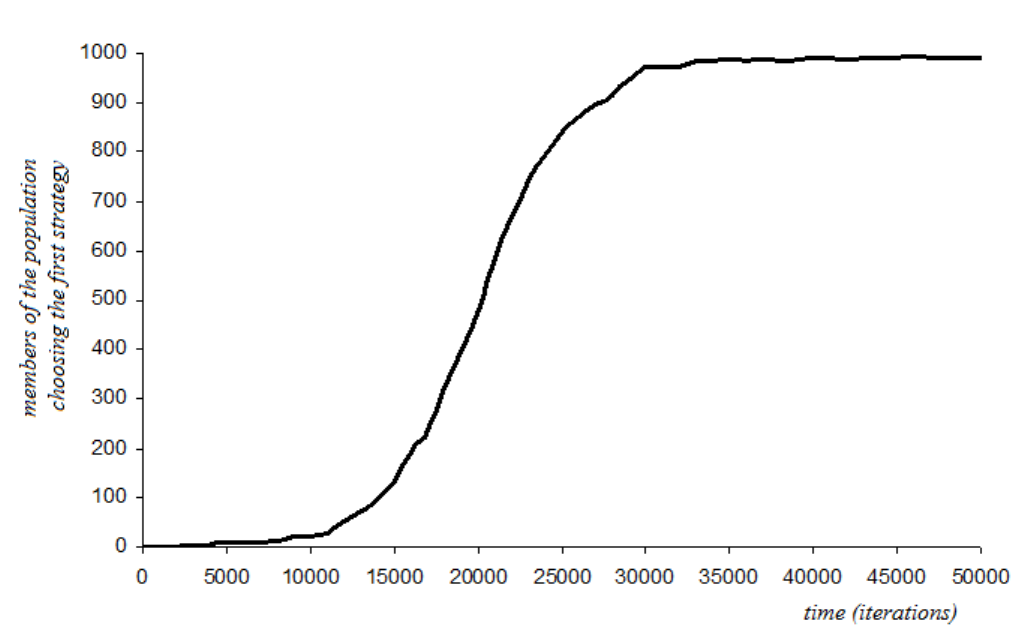
Figure 1. ‘ Hi-Lo ’ when all players are initially ‘stuck’ in the inefficient